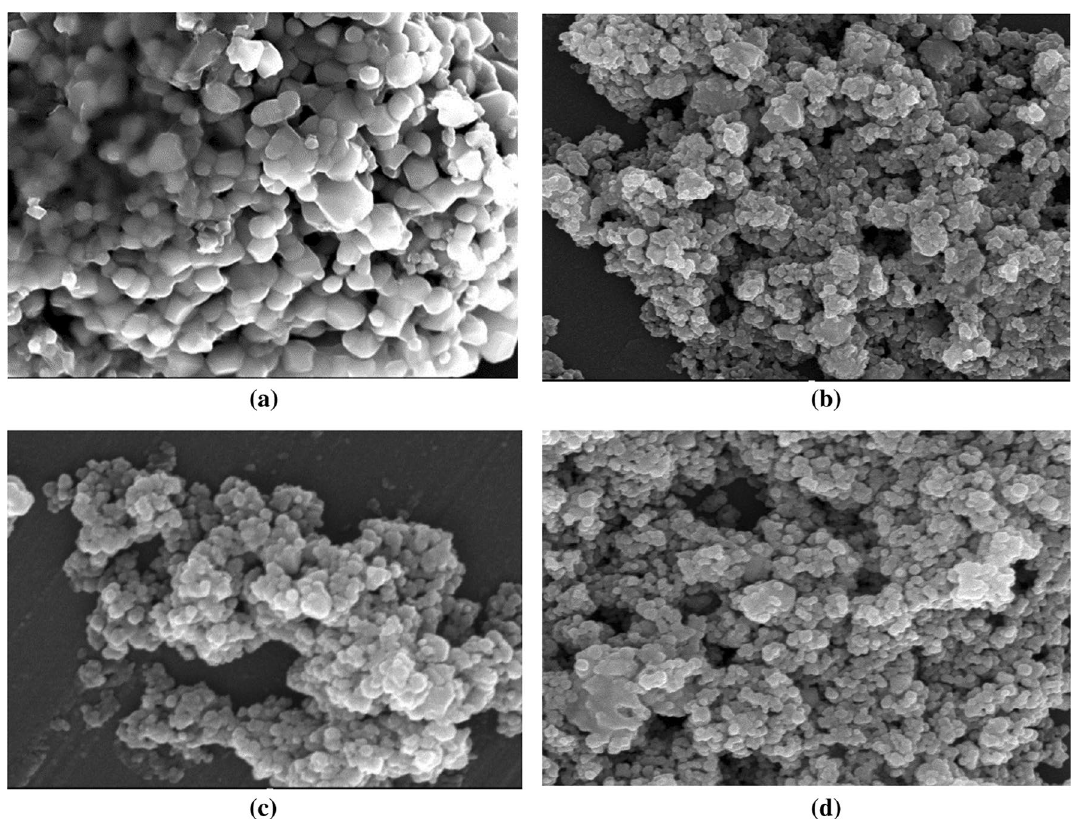
Figure 8. SEM micrographs of NZF samples ( a ) NZF, ( b ) N 0.25 ZF, ( c ) N 0.5 ZF and ( d ) N 0.75